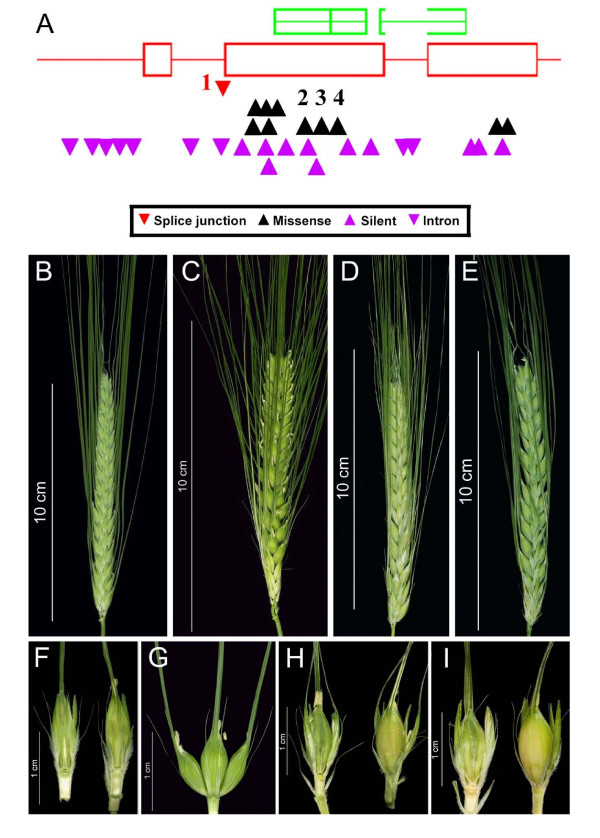
Tilling of the gene HvHox1 reveals new alleles of the two-rowed/six-rowed locus Vrs1. (A) Model of the gene HvHox1 (Vrs1) designed from output files of the software PARSESNP [58]. Gene structure and distribution as well the type of mutation discovered in a 1,270-bp region covering the entire open reading frame (ORF) of the gene are illustrated: exons = red open boxes, introns = red lines, conserved homeodomain-leucine zipper I-class homeobox domain (obtained from the BLOCKS database, [67]) = green boxes above the gene structure model. Mutations are indicated as small arrowheads below the gene structure model: purple = non-functional mutations, i.e., intron-located or synonymous mutations; black = non-synonymous mutations; and red = a splice junction mutation. Numbered arrowheads indicate mutations leading to phenotypic changes in M2 individuals 11910-1 (1), 3930-1 (2), 8408-1 (3), and 11657-1 (4), respectively. Detailed views of total inflorescences (B-E) and lateral spikelet morphology (F-I) are given for wild-type (two-rowed) 'Barke' (B, F), a six-rowed (hex-v) mutant (8408-1) (C, G), an Intermedium spike-d (Int-d) mutant (11657-1) (D, H), and mutant 3930-1 (E, I). Mutant 8408-1 possessed fully fertile and awned lateral spikelets (G), whereas the lateral spikelets of mutant 11657-1 exhibited shorter awns and only partial fertility, mostly in the basal lateral spikelets (H). The lateral spikelets of 3930-1 were significantly enlarged and tip-pointed compared to 'Barke,' but were sterile and not awned (I).